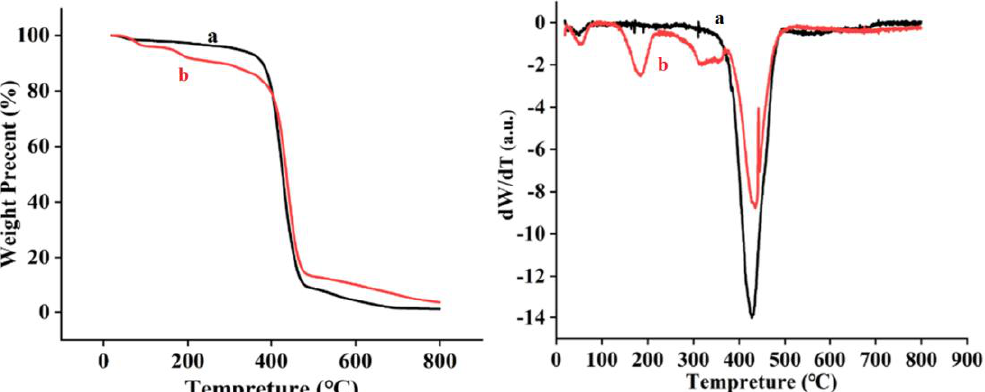
Figure 7. TGA curves and derivative thermogravimetric (DTG) curves for the (a) nylon6 nanofiber membranes and (b) nylon6/pig nail keratin composite nanofiber membranes.